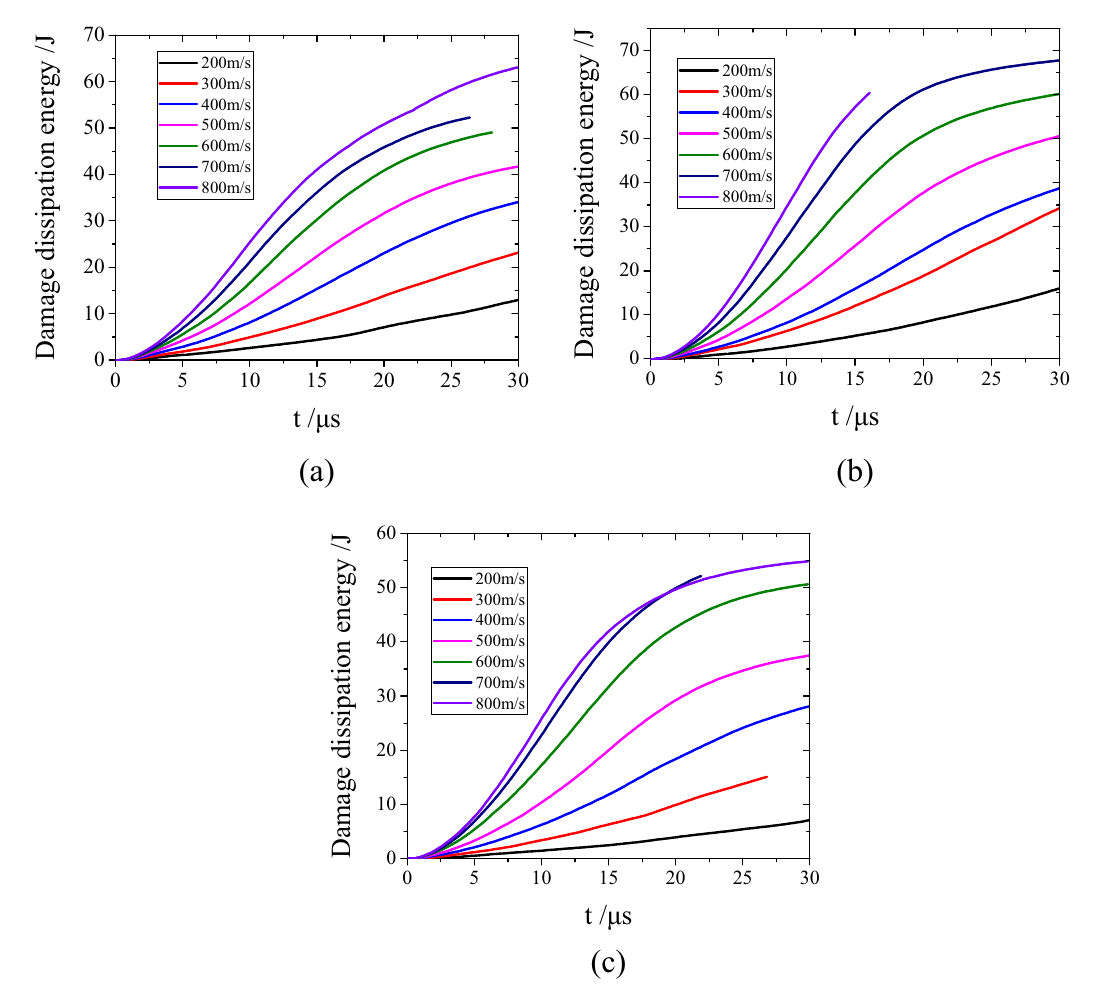
Figure 7: Damage dissipation energy of simulation: ( a ) carbon, ( b ) Kevlar, and ( c )